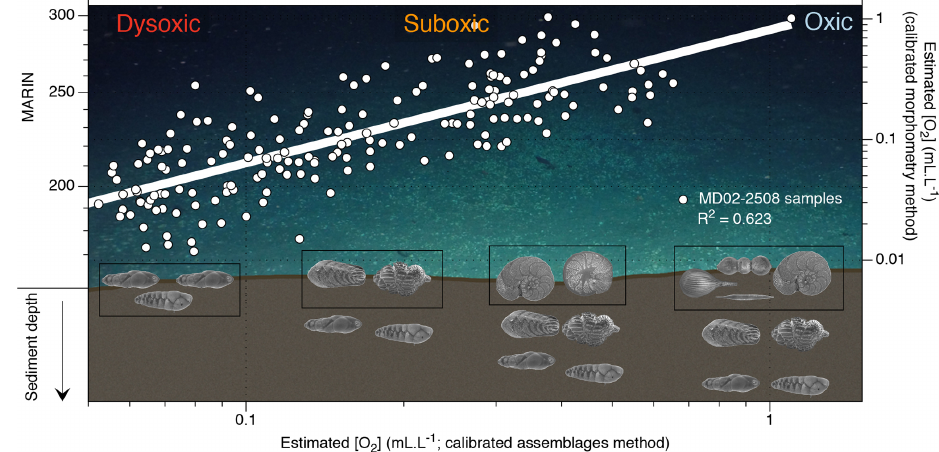
Figure 4. Conceptual graphic of the MARIN response of the top centimetres of benthic foraminiferal assemblage to [O 2 ] variations (back- ground image is courtesy of Erik Cordes, Temple University, BOEM Deep Search, USGS, NOAA HOV Alvin 2018, © Woods Hole Oceano- graphic Institution). The plot shows estimated [O2] using the assemblage method vs. estimated [O 2 ] using the morphometric method (and corresponding MARIN values) for Core MD02-2508. Black boxes show species example of the top-centimetre sample gradually replaced with an increase in BWO.